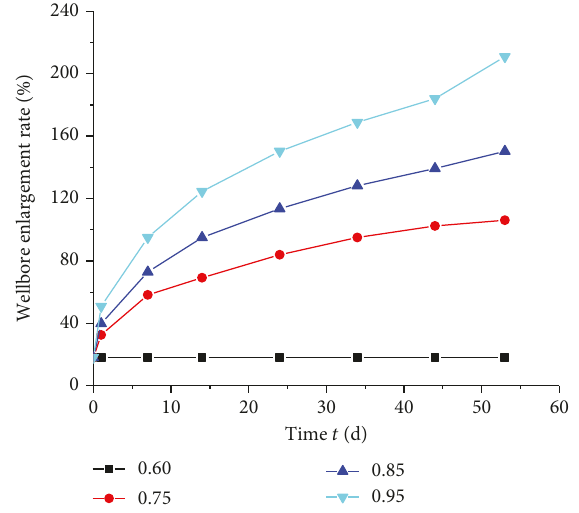
Figure 19: Curve of the wellbore enlargement rate with time under di ff erent drilling fl uid activities.